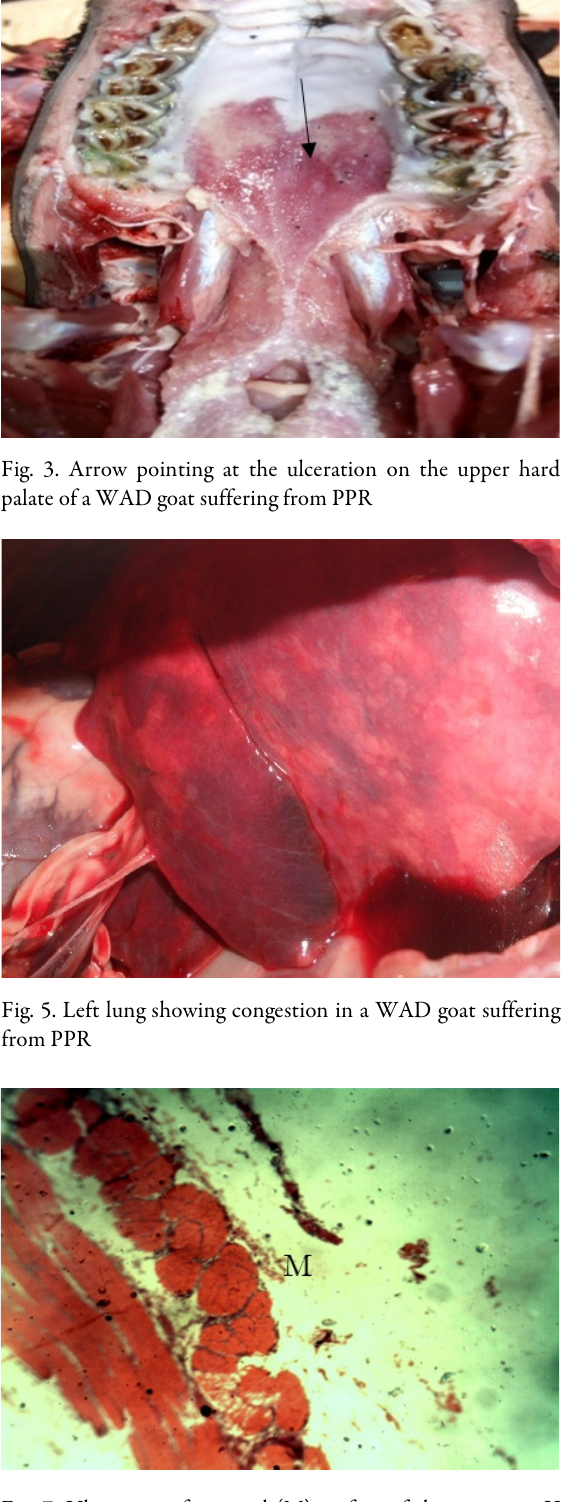
Fig. 7. Ulceration of mucosal (M) surface of the intestines X 100